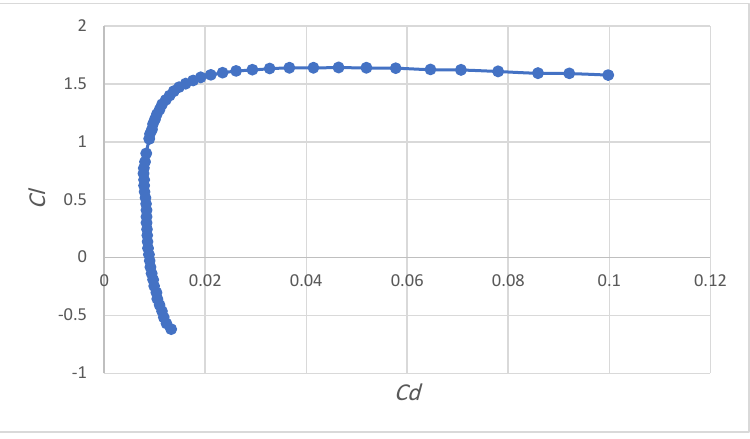
Figure 10. Variation of lift coefficient ( Cl ) vs. drag coefficient ( Cd ) for 3 blades of VAWT.